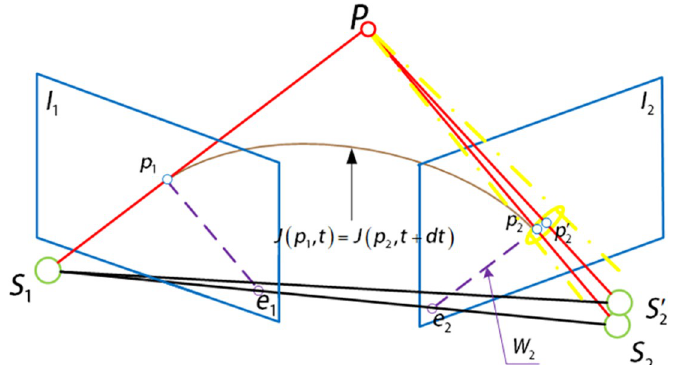
Fig 8. General diagram of feature matching algorithm.